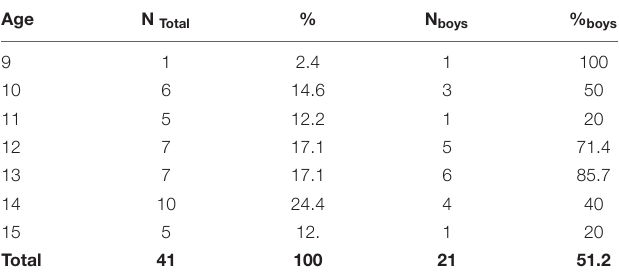
TABLE 1 | Frequency and percentage of age and